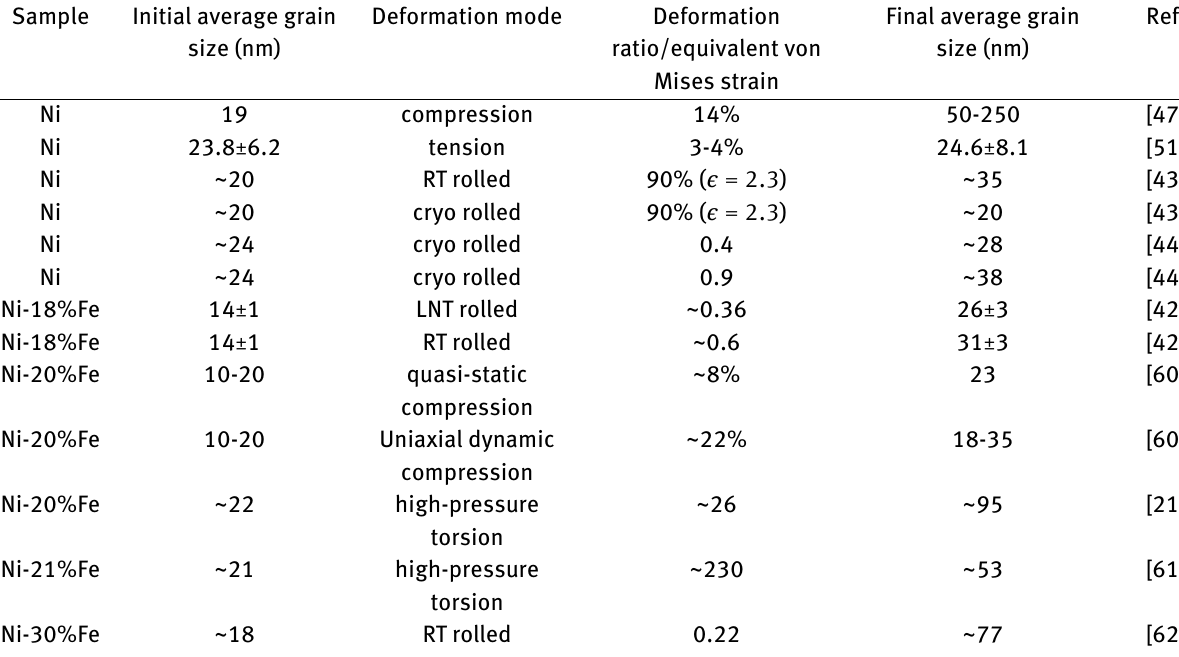
Table 2: A short summary of the grain size change for bulk electrodeposited NC Ni and Ni-Fe alloys after deformation treatment.